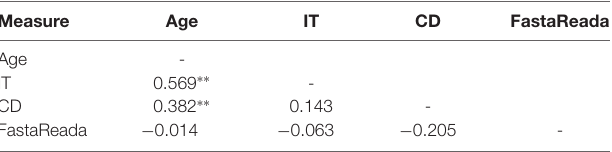
TABLE 4 | Spearman’s rank-order correlations between age, and scores on it, cd, and FastaReada. Measure Age IT CD